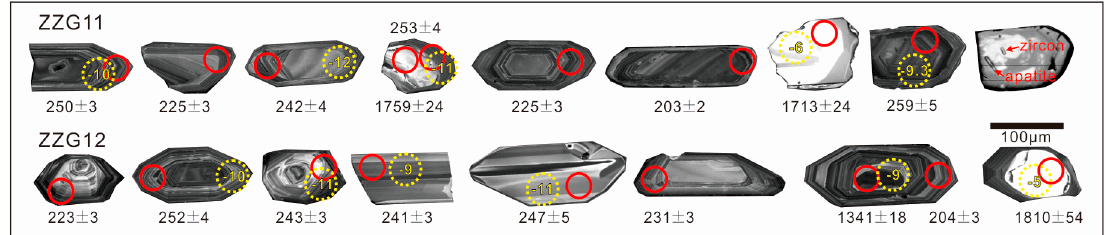
Figure 6. Representative cathodoluminescence images and photomicrographs of zircons derived from ZZG11 and ZZG12 with identified analytical spot, U-Pb age (Ma) and ε Hf (t) value. Red circle: U-Pb beam. Yellow dash circle: Hf beam.